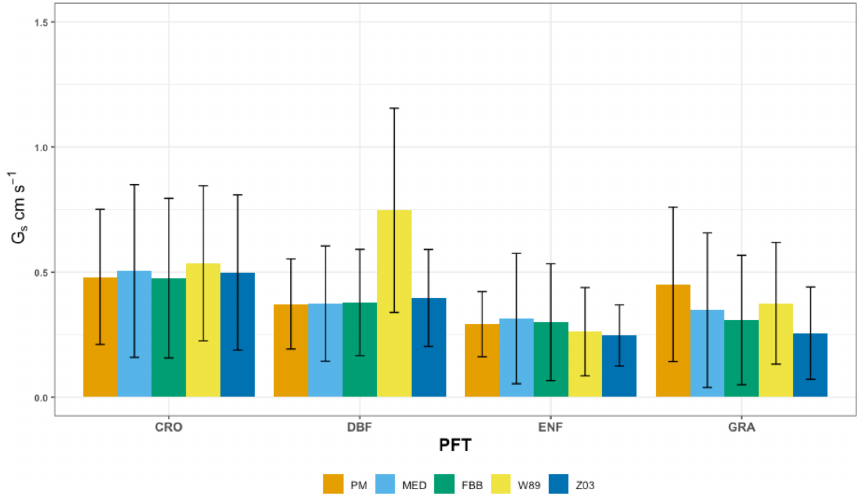
Figure 8. Average daytime canopy stomatal conductance ( G s ) computed with different stomatal conductance approaches for the four major PFTs. The error bars indicate 2 standard deviations. DBF: deciduous broadleaf forest; ENF: evergreen needleleaf forest; CRO: crop; GRA: